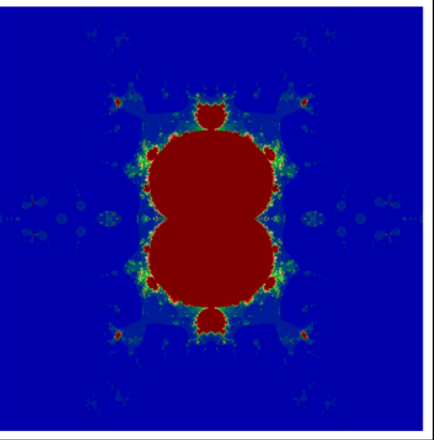
Figure 39. M-set via F-iteration for sin ( z 3 ) + c with image visual time = 140.4 s.